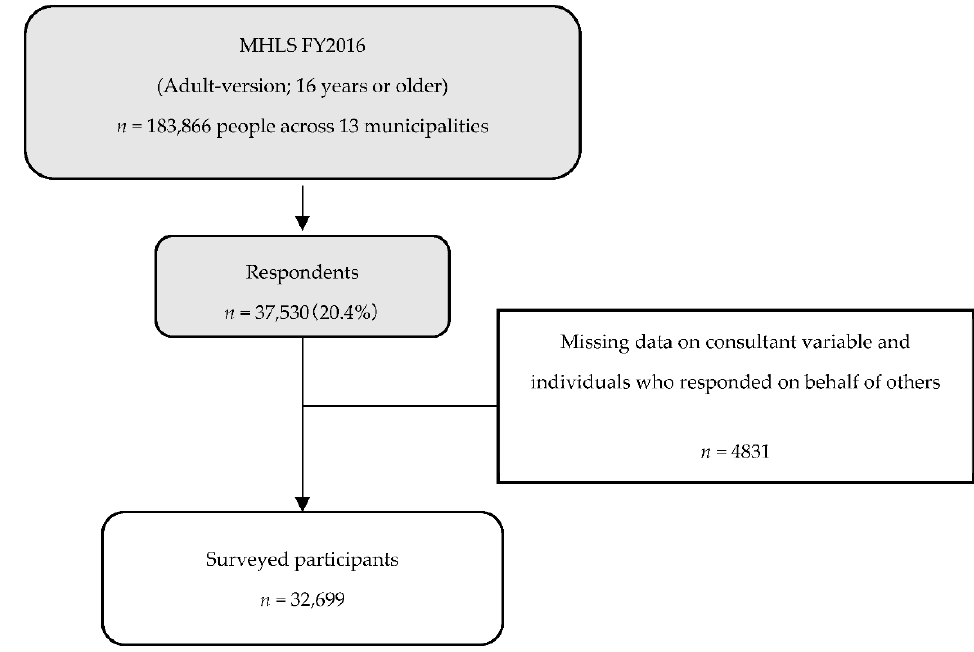
Figure 1. Selection of participants. MHLS: Mental Health Lifestyle Survey; FY: Fiscal Year.